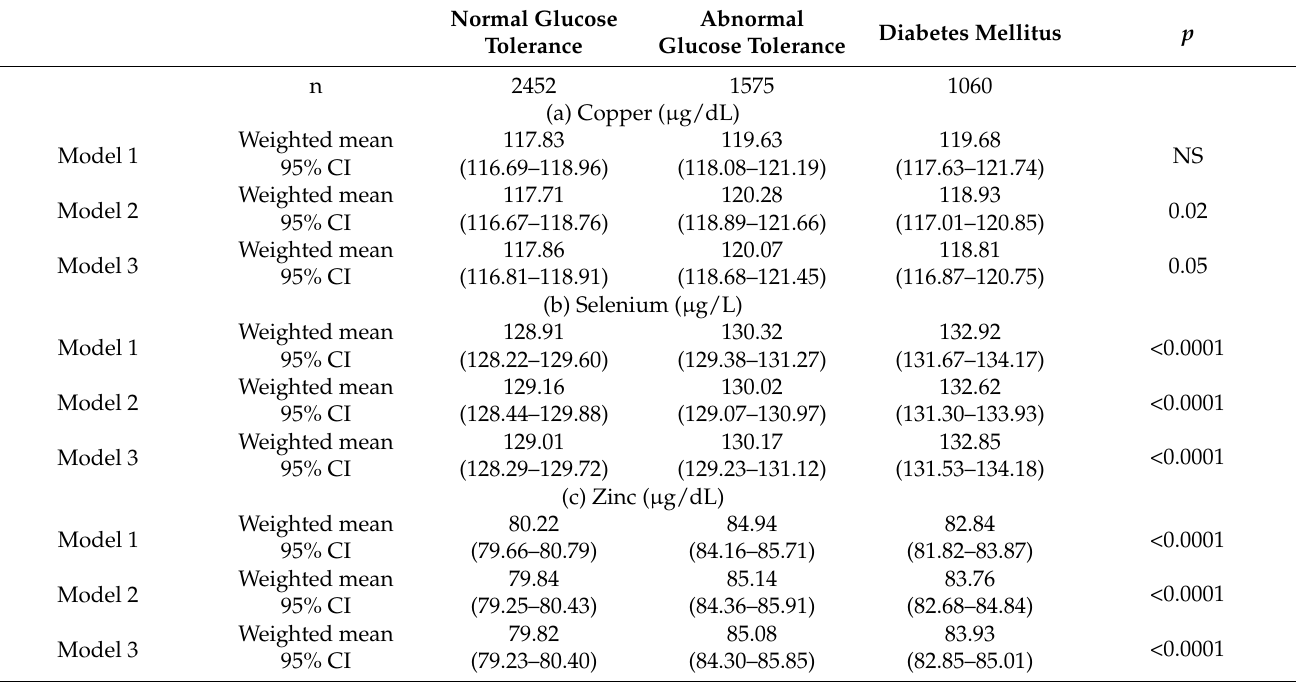
Table 6. Comparison of serum copper, selenium, and zinc concentrations by the states of glucose tolerance.